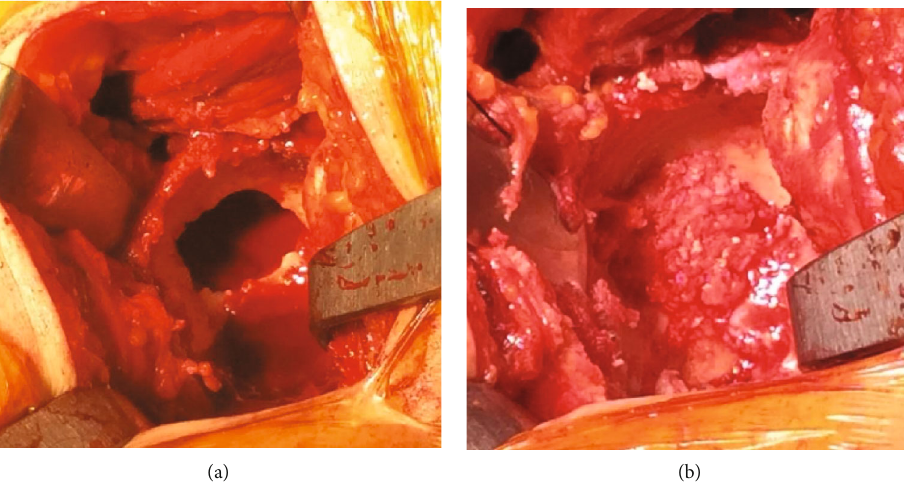
Figure 4: Intraoperative fi ndings (a) after curettage of the acetabular bone absorption lesion through a window created in the acetabular dome and (b) after impaction bone grafting of the resulting